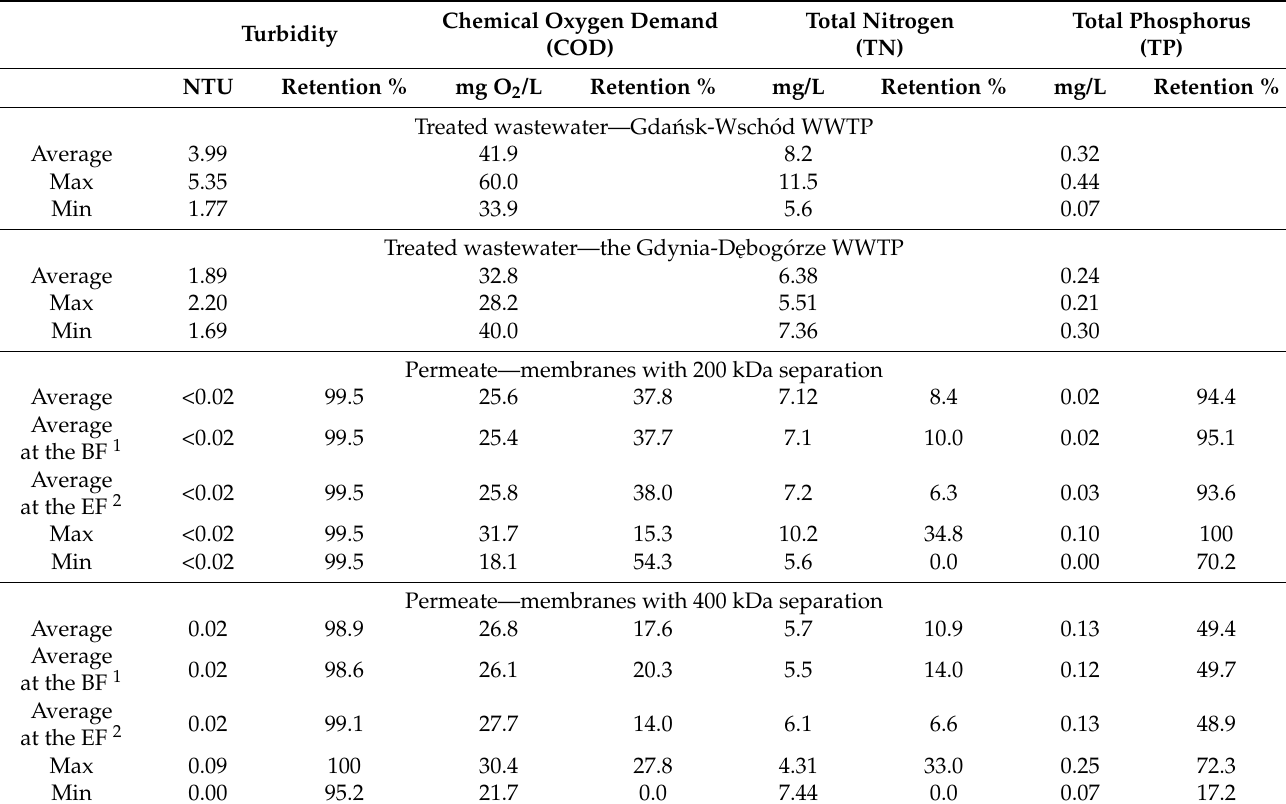
Table 1. Physico-chemical parameters of treated wastewater before and after